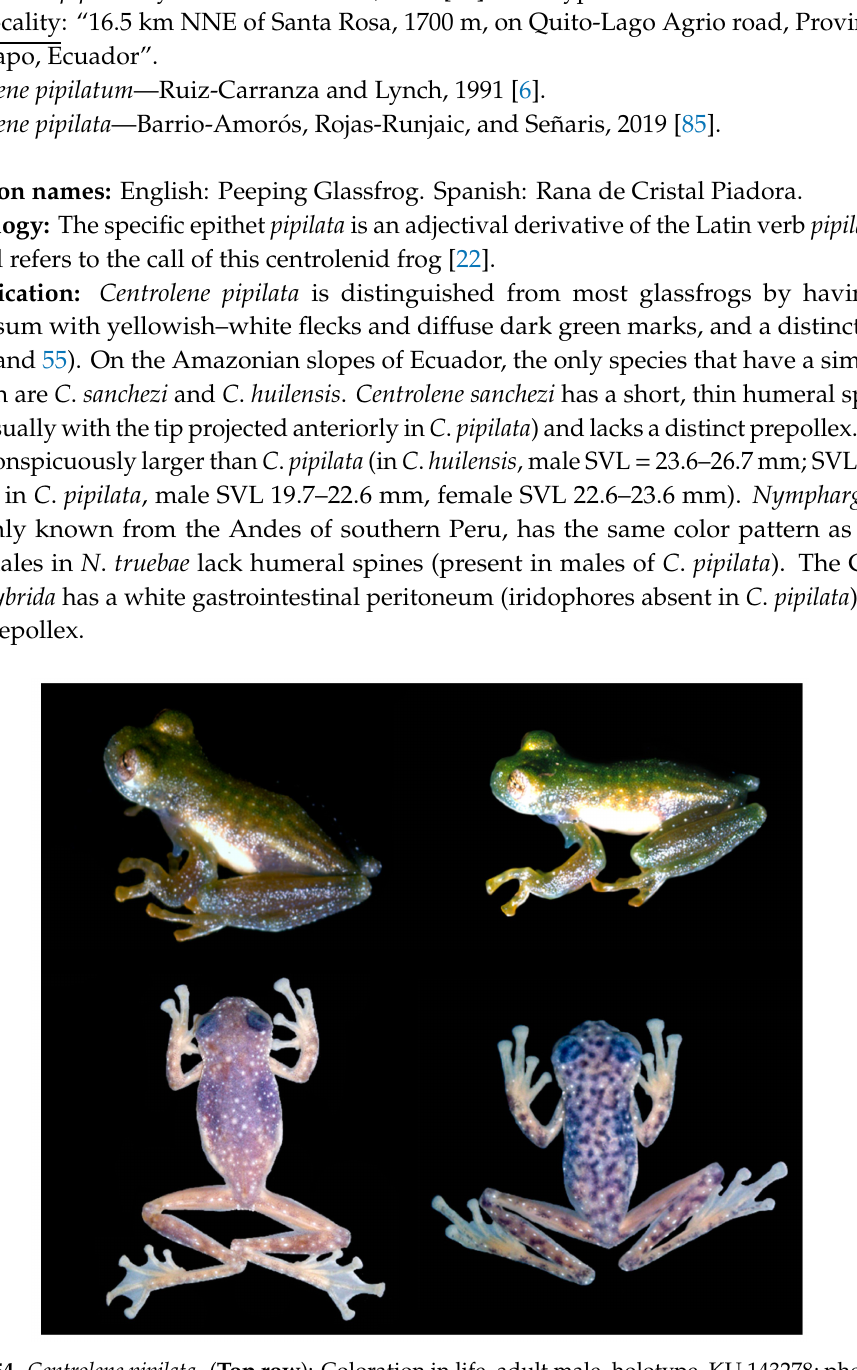
Figure 54. Centrolene pipilata . ( Top row ): Coloration in life, adult male, holotype, KU 143278; photos by William E. Duellman. ( Bottom row ): Coloration in preservative of KU 178155 ( left ) and KU 143287 ( right ); photos by Juan M.